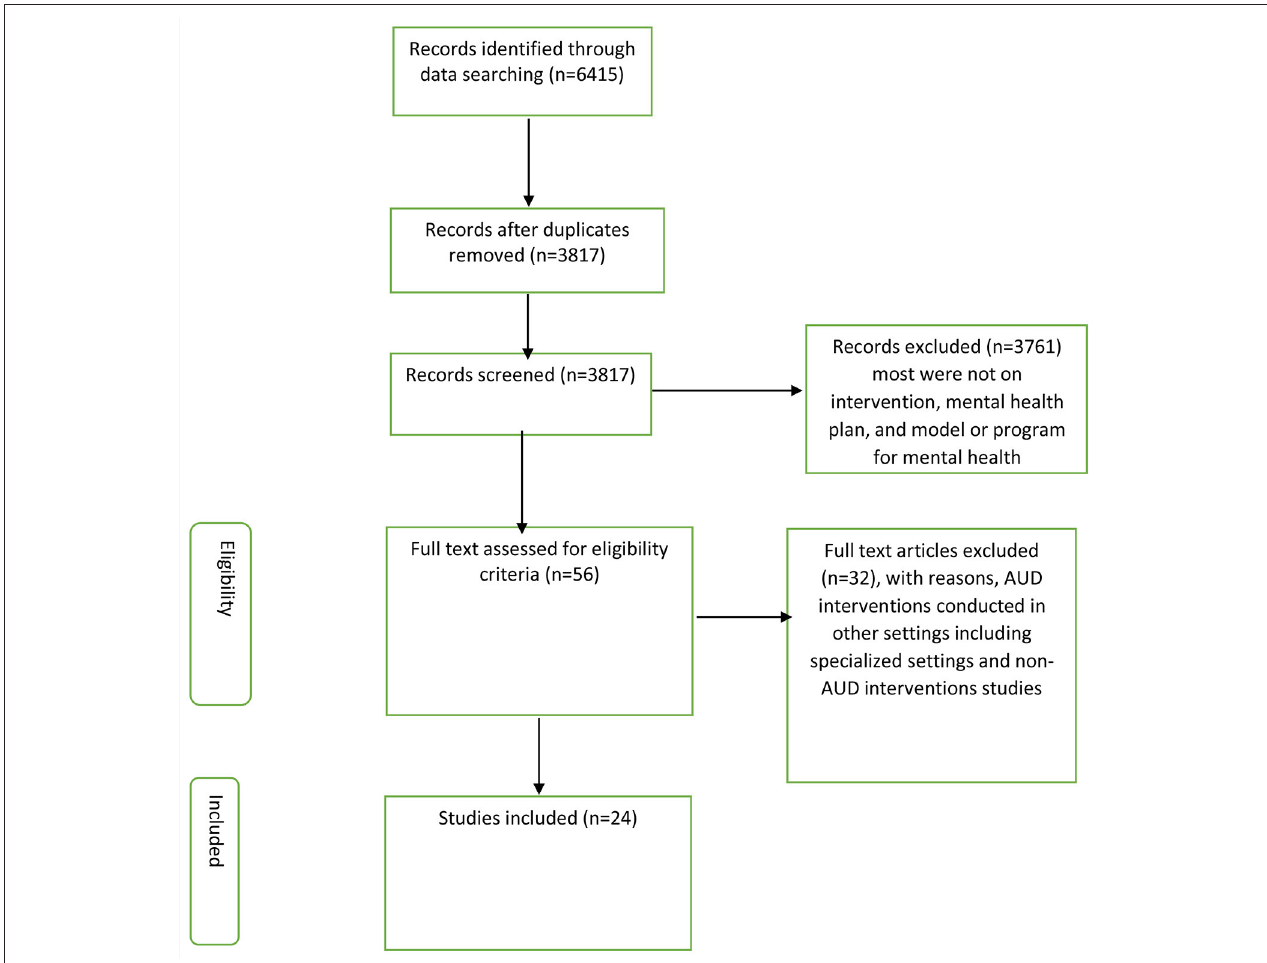
FIGURE 1 | Flow diagram of the identified citation and included